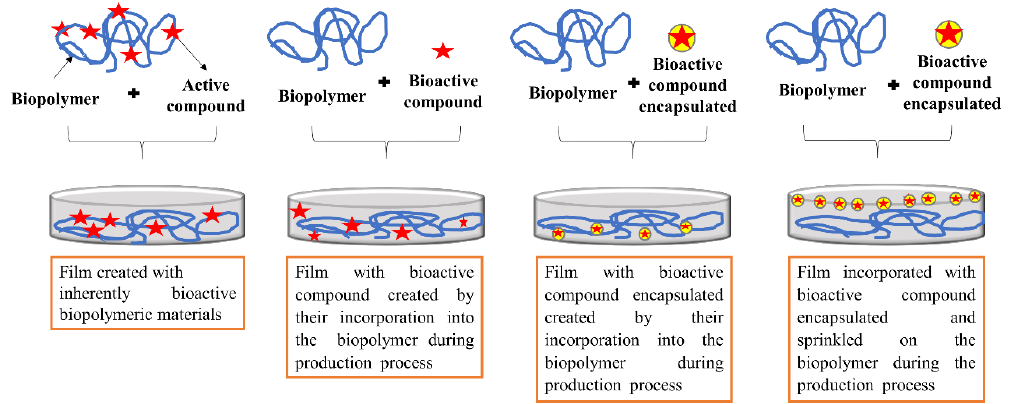
Figure 3. Schematic preparation of bioactive films agro-based polymers incorporated with plant-derived bioactive compounds.